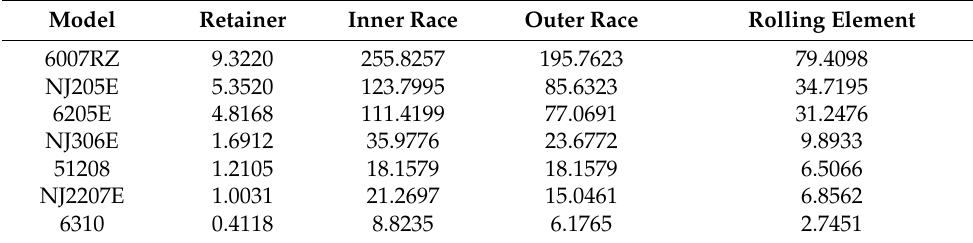
Table 3. Main order of differential steering gearbox in each gear.